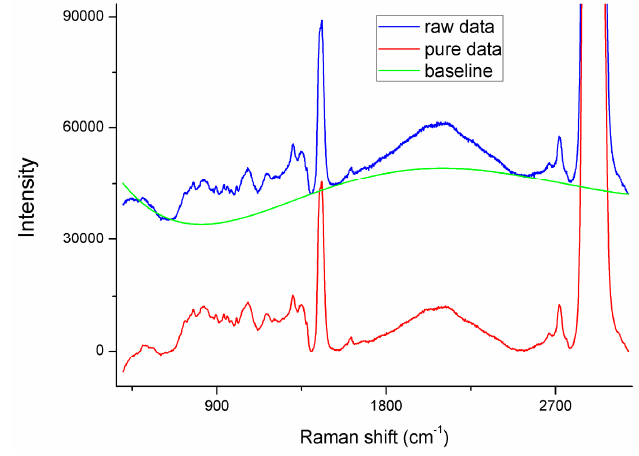
Figure 2. Data pre-processing for Raman spectra of oil samples.